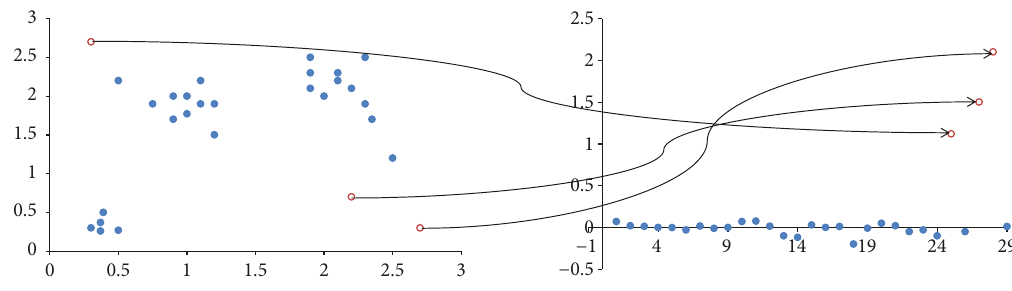
Figure 6: The corresponding points of outliers.